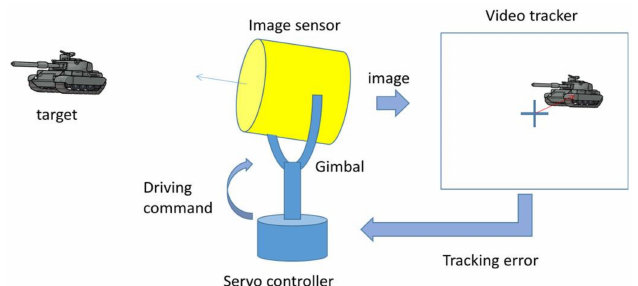
Figure 1. Automatic tracking procedure of an electro-optical